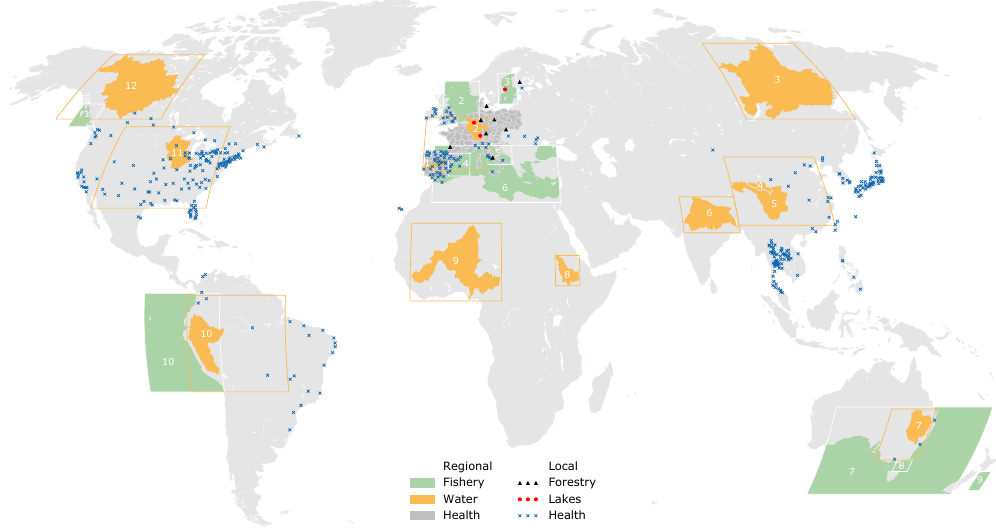
Figure 7. ISIMIP focus regions. The coordinates of the numbered regions are listed in Table